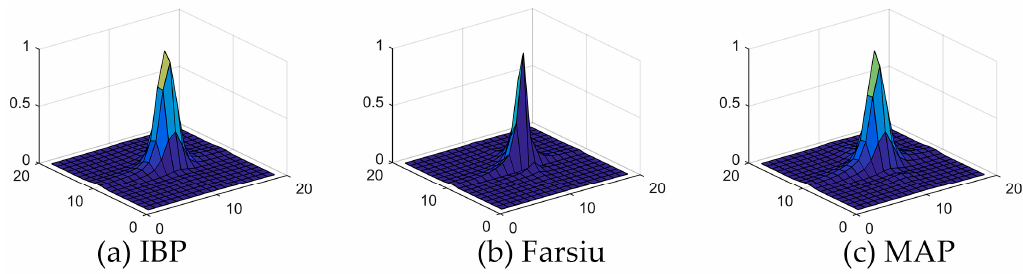
Figure 6. The PSFs between the upsampled reference image and the reconstructed HR images of the offshore aquaculture area.